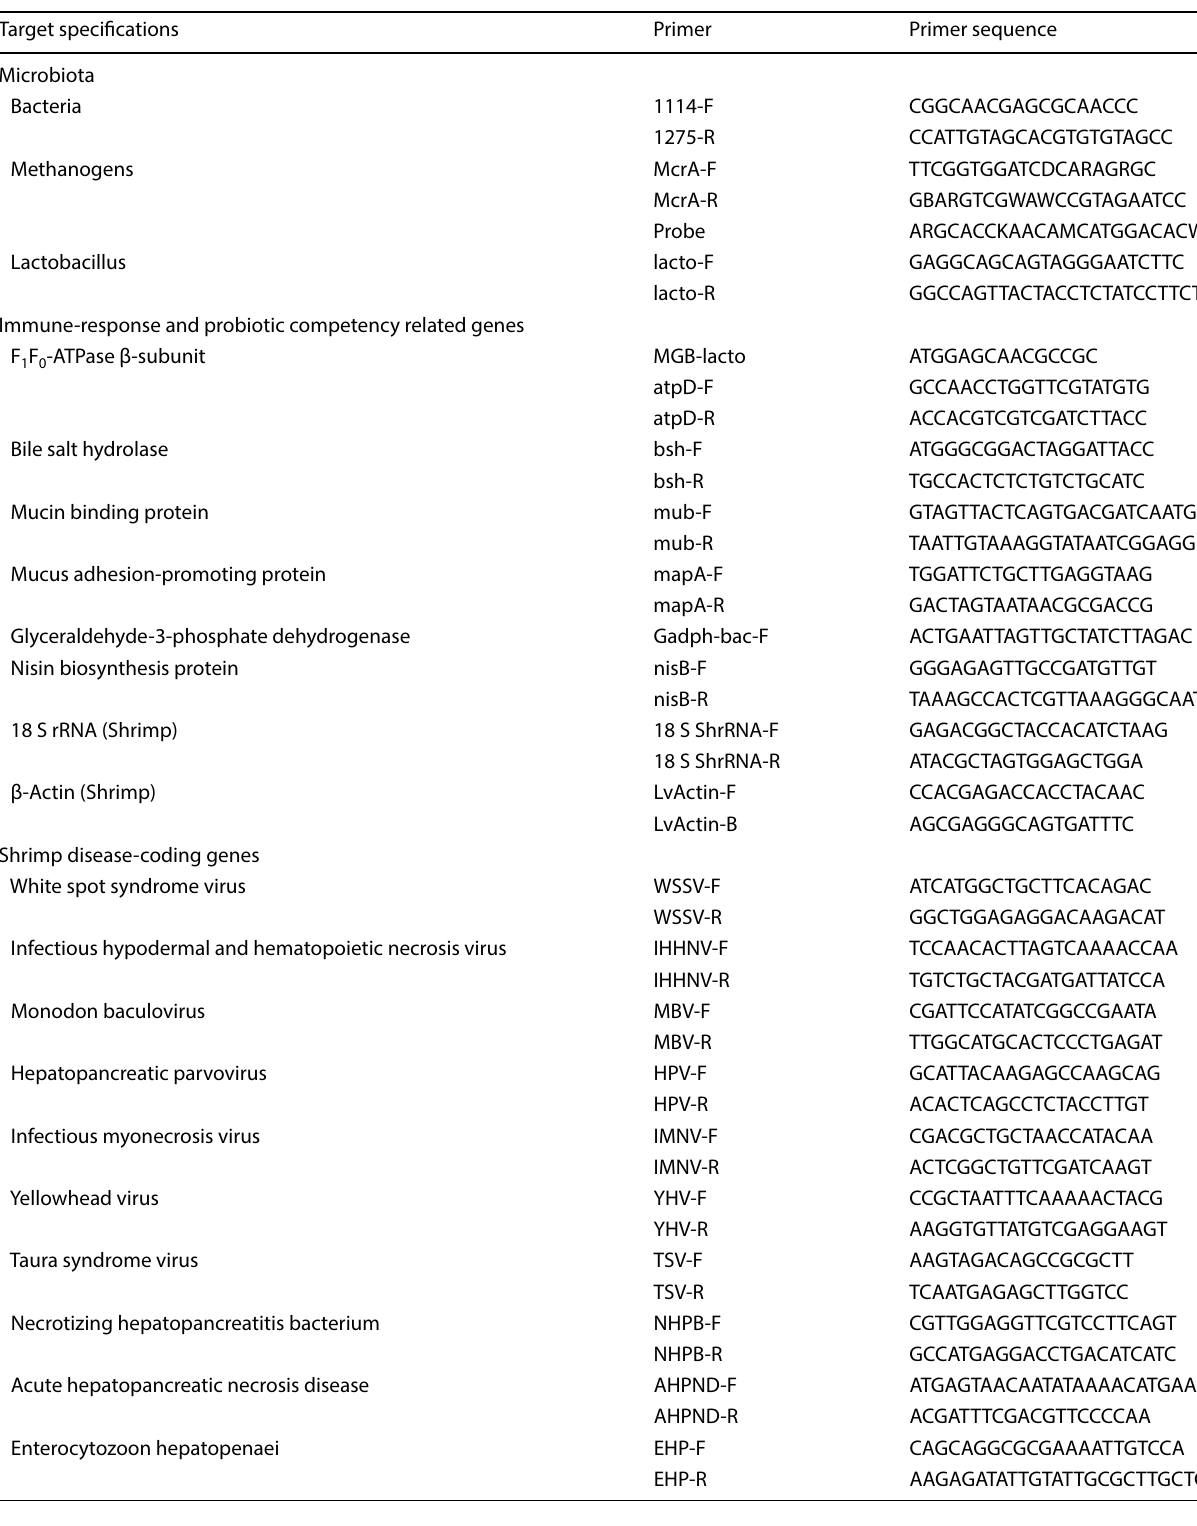
Table 1 Details of PCR and RT-PCR primers for studying probiotics competency, biofilm-forming efficiency, Biofloc microbiota, and shrimp